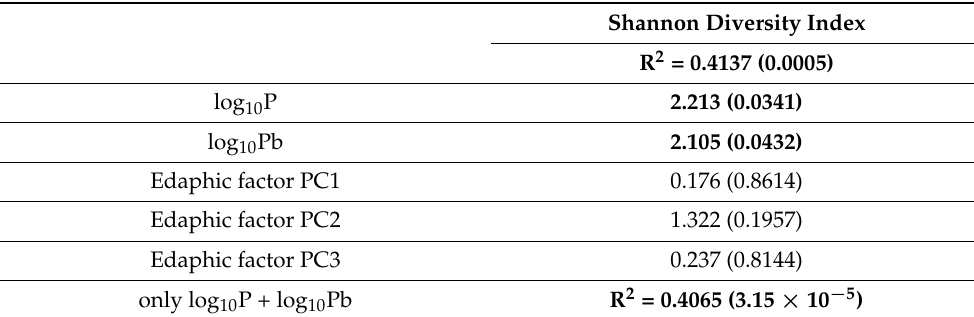
Table 2. Main edaphic factors predicting the Shannon diversity index of rhizosphere bacterial communities.